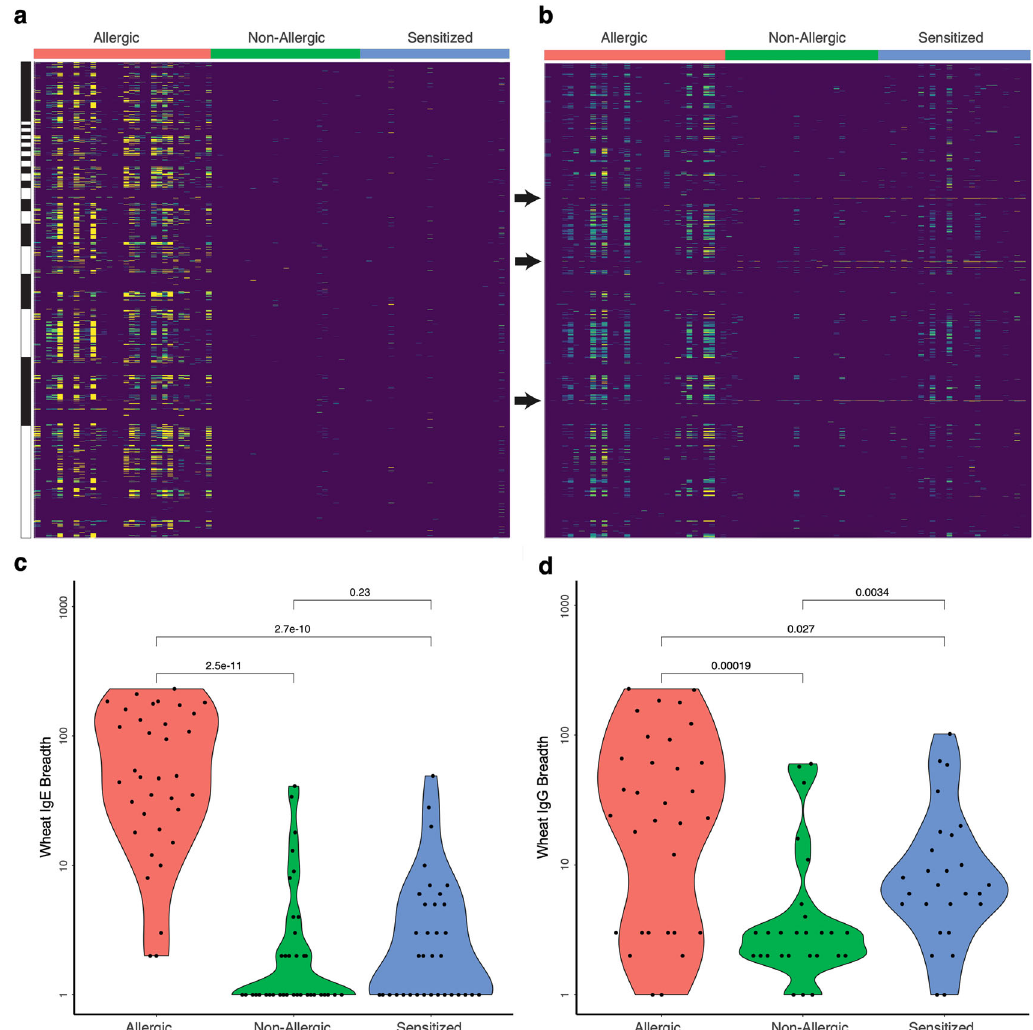
Fig. 3 IgE and IgG reactivity of wheat peptides. Serum donors (columns in a , b ) had been clinically de fi ned as wheat allergic, wheat non-allergic, and wheat sensitized. Rows correspond to wheat peptides tiled from each protein ’ s N- to C-terminus, arranged by increasing size (top to bottom). Data in a are from IgE pro fi ling; data in b are from IgG pro fi ling. c Comparison of the IgE anti-wheat antibody breadths between patient groups. d Comparison of the IgG anti-wheat antibody breadths between patient. For b – d — wheat allergic ( n = 32), wheat non-allergic ( n = 27), and wheat sensitized ( n = 27). Signi fi cance values in both c and d were de fi ned via two-sided Wilcox ranked sum test (with no multiple hypothesis test corrections). Source data are provided as